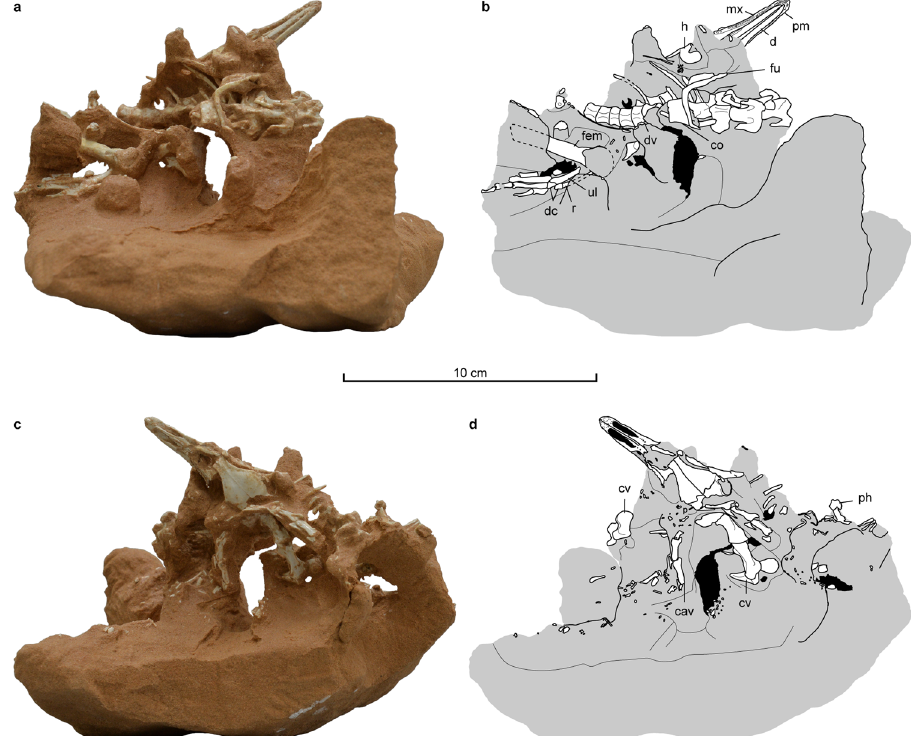
Fig. 1 Natovenator polydontus (MPC-D 102/114, holotype). Photographs ( a , c ) and line drawings ( b , d ) of the main block containing most of the specimen in opposite views. cav caudal vertebra, co coracoid, cv cervical vertebra, d dentary, dc distal carpal, dv dorsal vertebra, fem femur, fu furcula, h humerus, mx maxilla, ph phalanx, pm premaxilla, r radius, ul